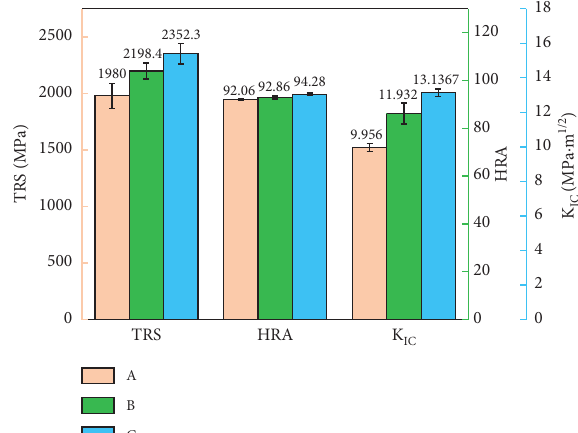
Figure 10: Histogram showing comparison of mechanical properties. Five samples were recorded for each sample, and the error bars represent differences between the maximum and minimum values of five recordings from the three independent samples.